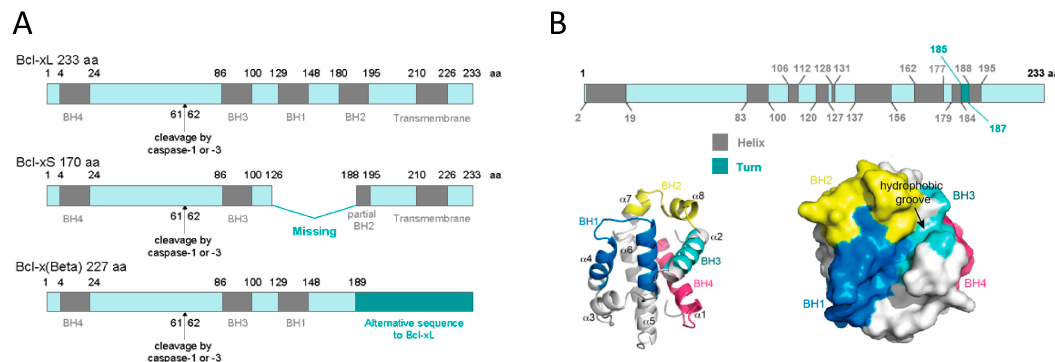
Figure 1. BCL-xL protein structure. ( A ) BCL-xL, BCL-xS and BCL-x β isoforms. This representation shows the presence of the BH domains as well as the cleavage site by caspase-1 or -3. ( B ) BCL-xL primary, secondary, and tertiary structures. The primary structure shows the linear position of helices and turns; the secondary structure represents the 3D position of the eight helices and the four BH domains; and the tertiary structure reveals the hydrophobic groove (adapted from Lee and Fairlie, IJMS 2019 [24] ).